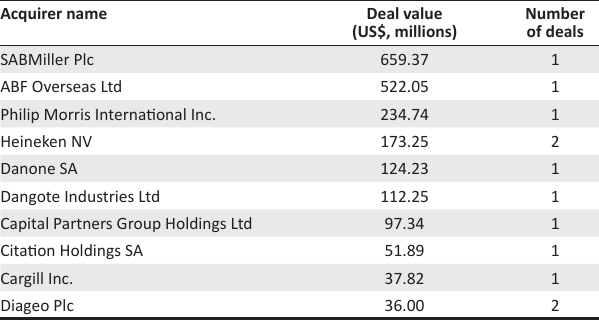
TABLE 10: Agricultural mergers and acquisitions inflows into South Africa by company, 2003–2014.